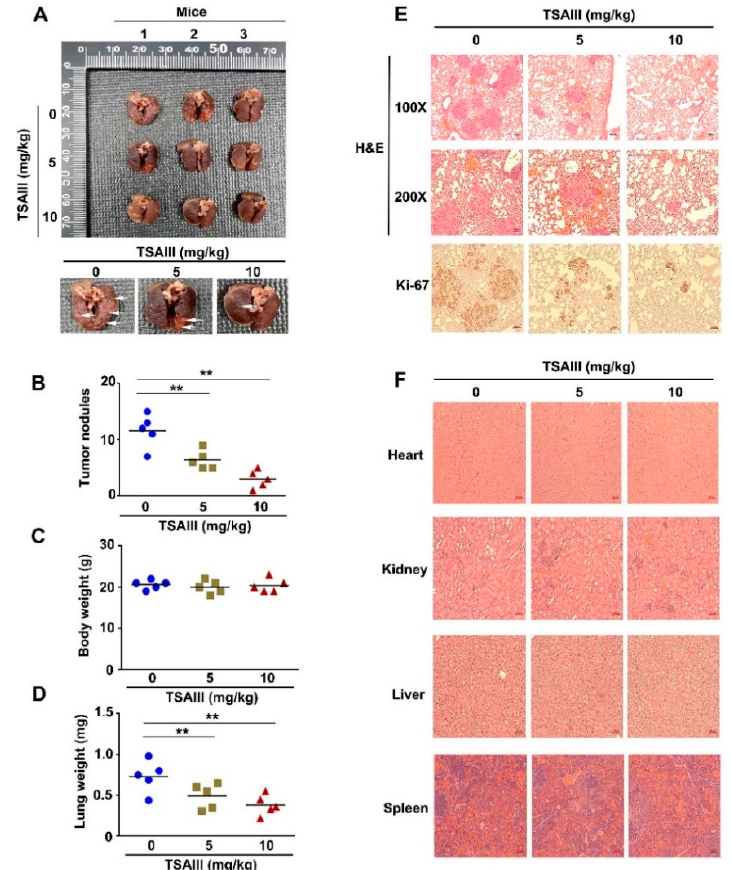
Figure 8. Effects of TSAIII on cervical cancer metastasis in immunodeficient mice. In animal assay of lung metastasis, human cervical cancer cells (SiHa) were harvested and injected into the tail veins of immunodeficient, female BALB/c nude mice. Mice were then administered with TSAIII (5 and 10 mg/kg) through oral gavage. After 1 month, mice were sacrificed and analyzed to observe ( A ) lung metastasis of mice. ( B ) The number of lung metastasis nodules, ( C ) body weight and ( D ) lung weight of mice were counted. ( E ) The histopathology of the lungs in metastatic tumor-bearing mice was observed. The lungs of mice were fixed in neutral-buffered formalin and stained with hematoxylin and eosin (100 × and 200 × magnification). ( F ) Drug toxicity of TSAIII was evaluated in mice, which showed no organ damage in heart, kidney, liver and spleen. ** p < 0.01 vs. control group (mean ± SE; n =